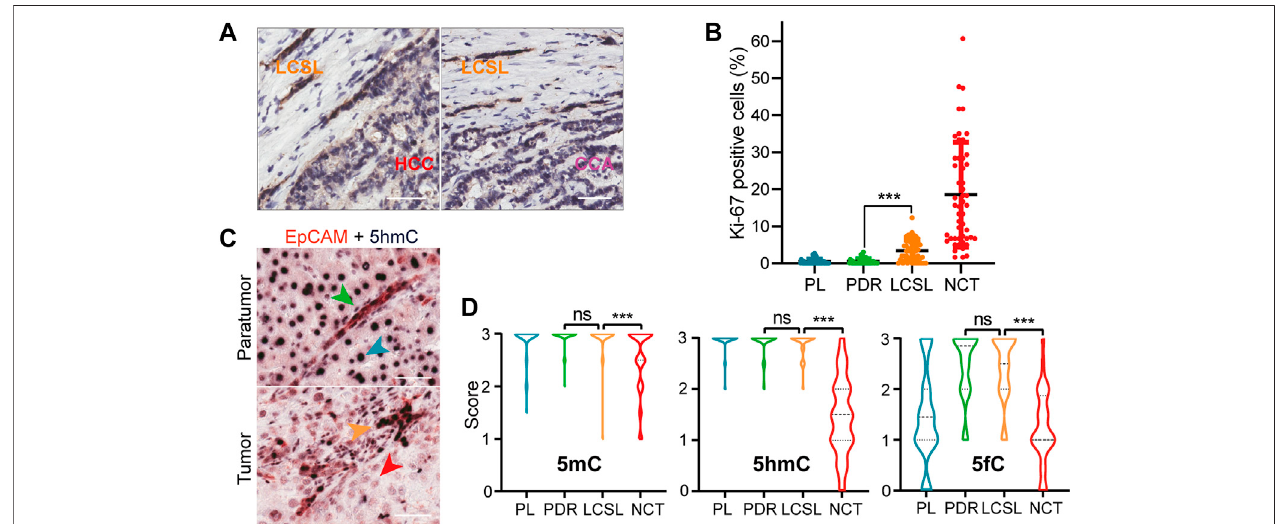
FIGURE1| CharacterizationofLCSLcellsinlivercancerpatients. (A) RepresentativetransitionregionsatthejunctionofLCSLcellsandHCCcellsorCCAcells(EpCAM immunostaining)inP2tumortissues.Scalebar,50 μ m. (B) DotplotshowsthepercentagesofKi-67-positivecellsinthefourcelltypesof50PLCpatientswithobviousLCSL cells( SupplementaryTableS1 ).Eachdotrepresentsthemeanvalueof fi verandomlyselectedequal fi eldsofIHCimagesfromonepatient.NCT,non-CSCtumorcells.Data are presented as the mean ± SD. ***, p < 0.001 by Wilcoxon matched-pairs signed rank test. (C) Representative double immunostaining of EpCAM (red) and 5hmC (dark purple) in one HCC sample with LCSL cells. The green, blue, yellow and red arrowheads indicate PDR, PL, LCSL and HCC cells, respectively. Scale bar, 50 μ m. (D) Statistical analysis of 5mC, 5hmC and 5fC staining of liver cancer samples. NCT, non-CSCtumor cells. For 5mC and 5hmC, n = 65; for 5fC, n = 34. Data are presented as violin plots with horizontal bars indicating the mean ± SD. ***, p < 0.001 by Wilcoxon matched-pairs signed-rank test; ns, not signi fi cant.